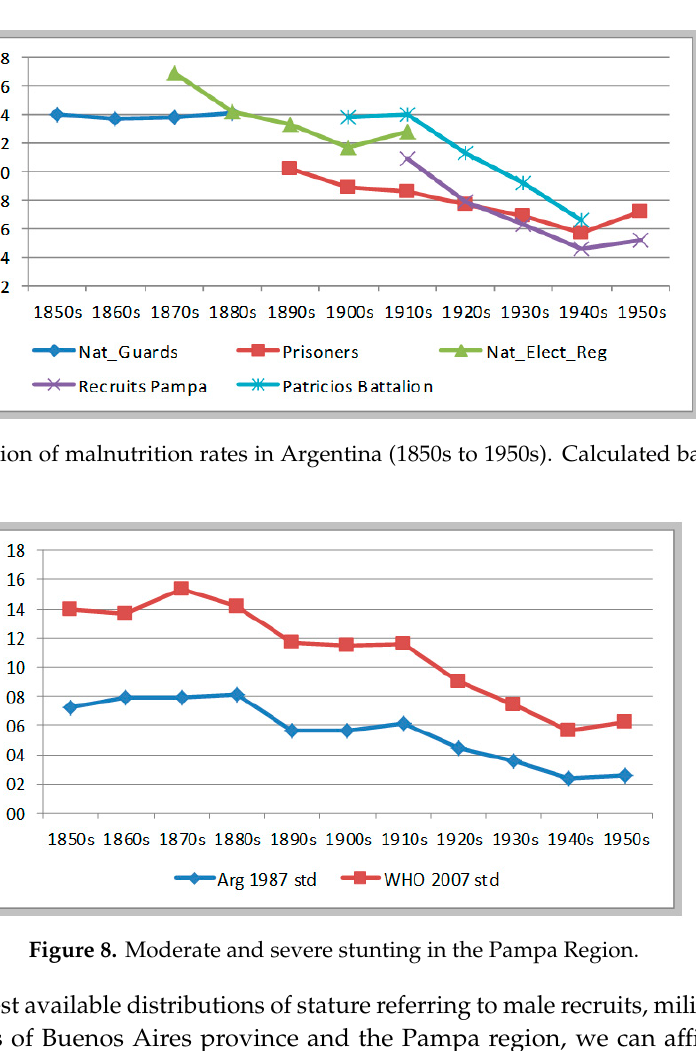
Figure 6. Evolution of malnutrition rates in Argentina (1850s to 1950s). Calculated based on Argentine 1987 standards.